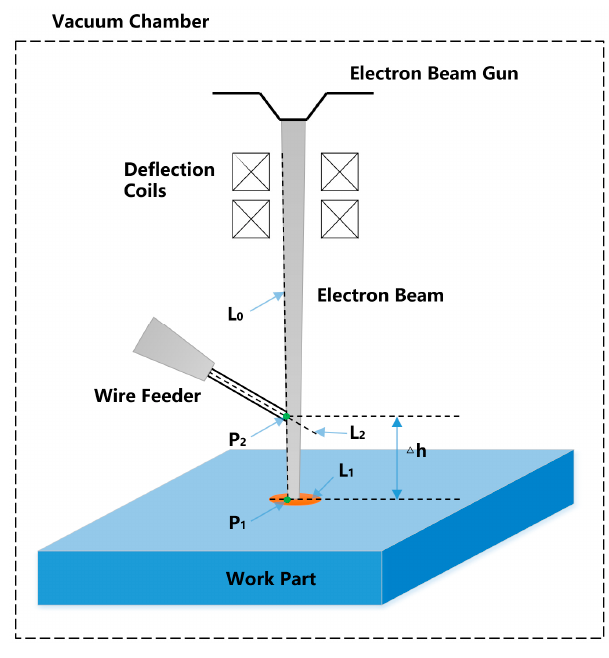
Figure 1. Definition of droplet transfer distance.